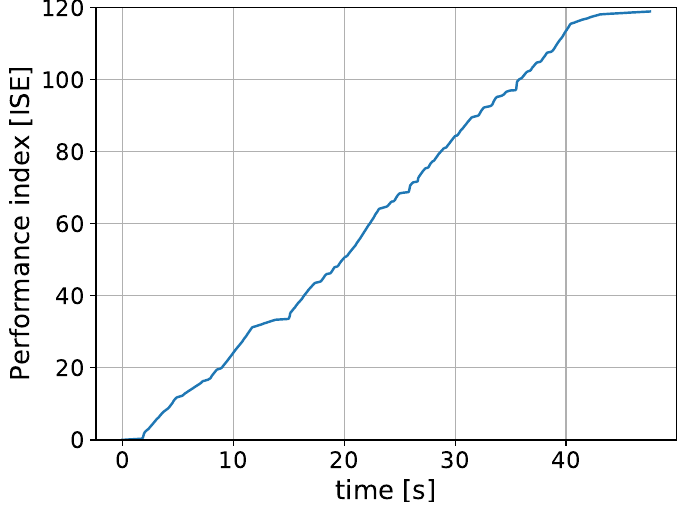
Figure 8. The ISE performance index obtained from the data in Figure